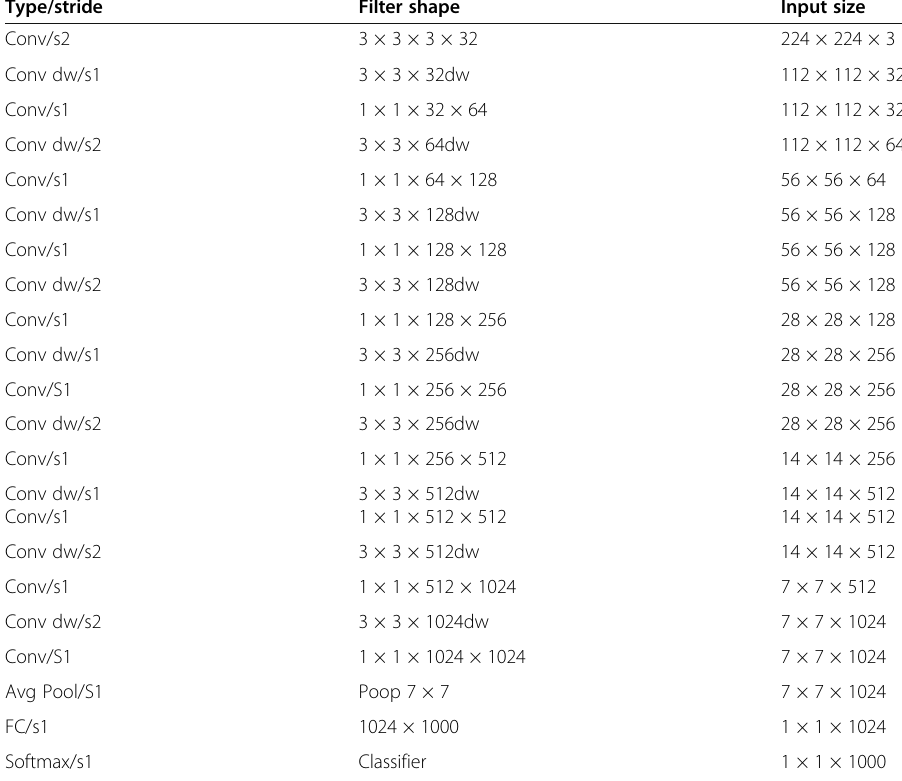
Table 6 MobileNet network structure Type/stride Filter shape